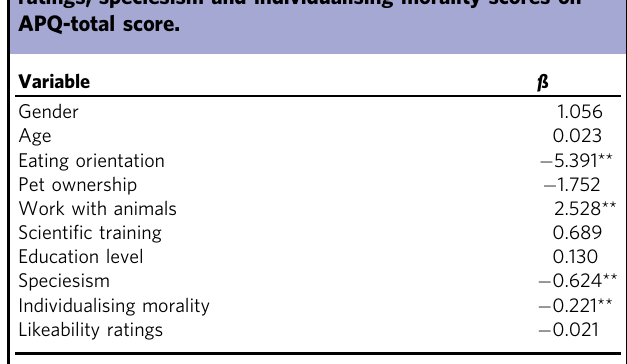
hierarchical linear regression of demographic variables, likeability ratings, speciesism and individualising morality scores on APQ-total score.